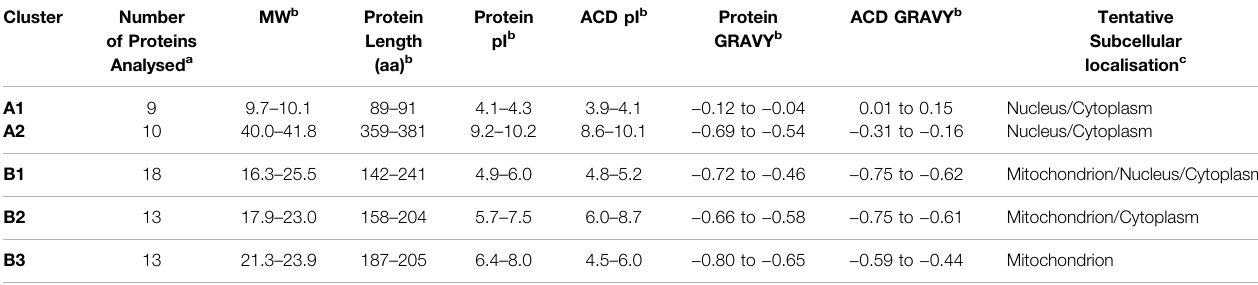
TABLE 1 | Physicochemical properties of monomeric sHsps of annelids. Sizes (MW: molecular weight), isoelectric points (pI), and GRAVY values for the whole protein and the ACD region (between β 3 and β 9) are indicated. Tentative subcellular localizations for each cluster are also shown. Cluster Number of Proteins Analysed a